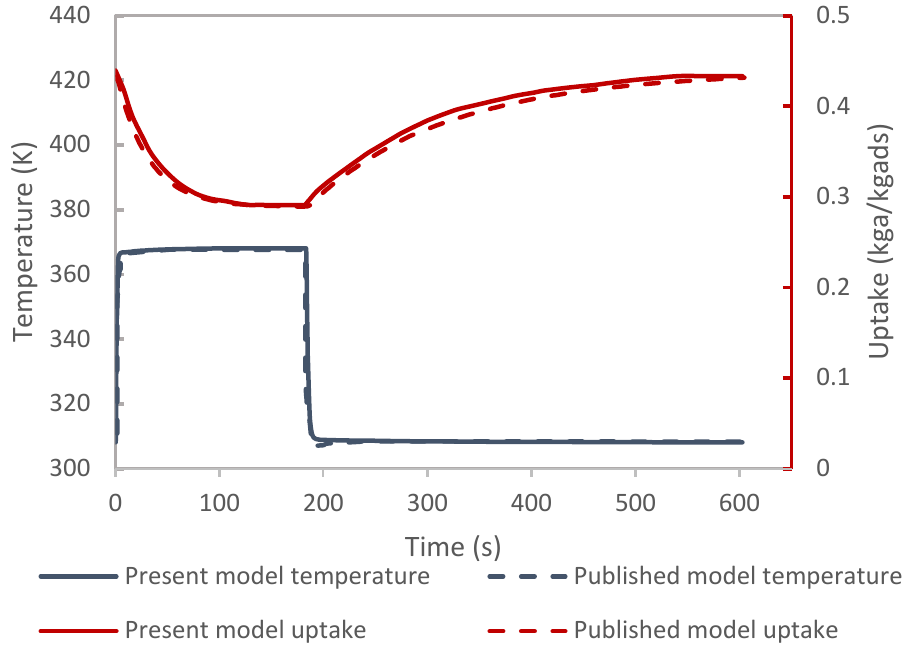
Figure 4. The comparison between the data obtained from the present study and those published in reference [34].